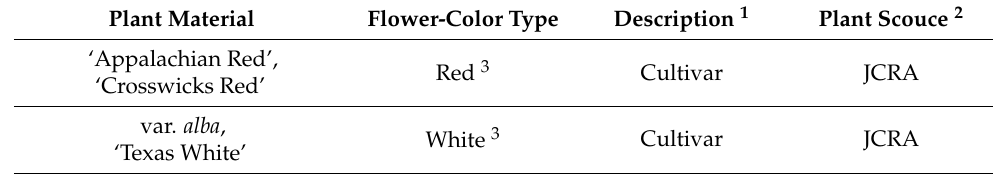
Table 1. Eastern redbud ( C. canadensis L.) plant material, flower types, and